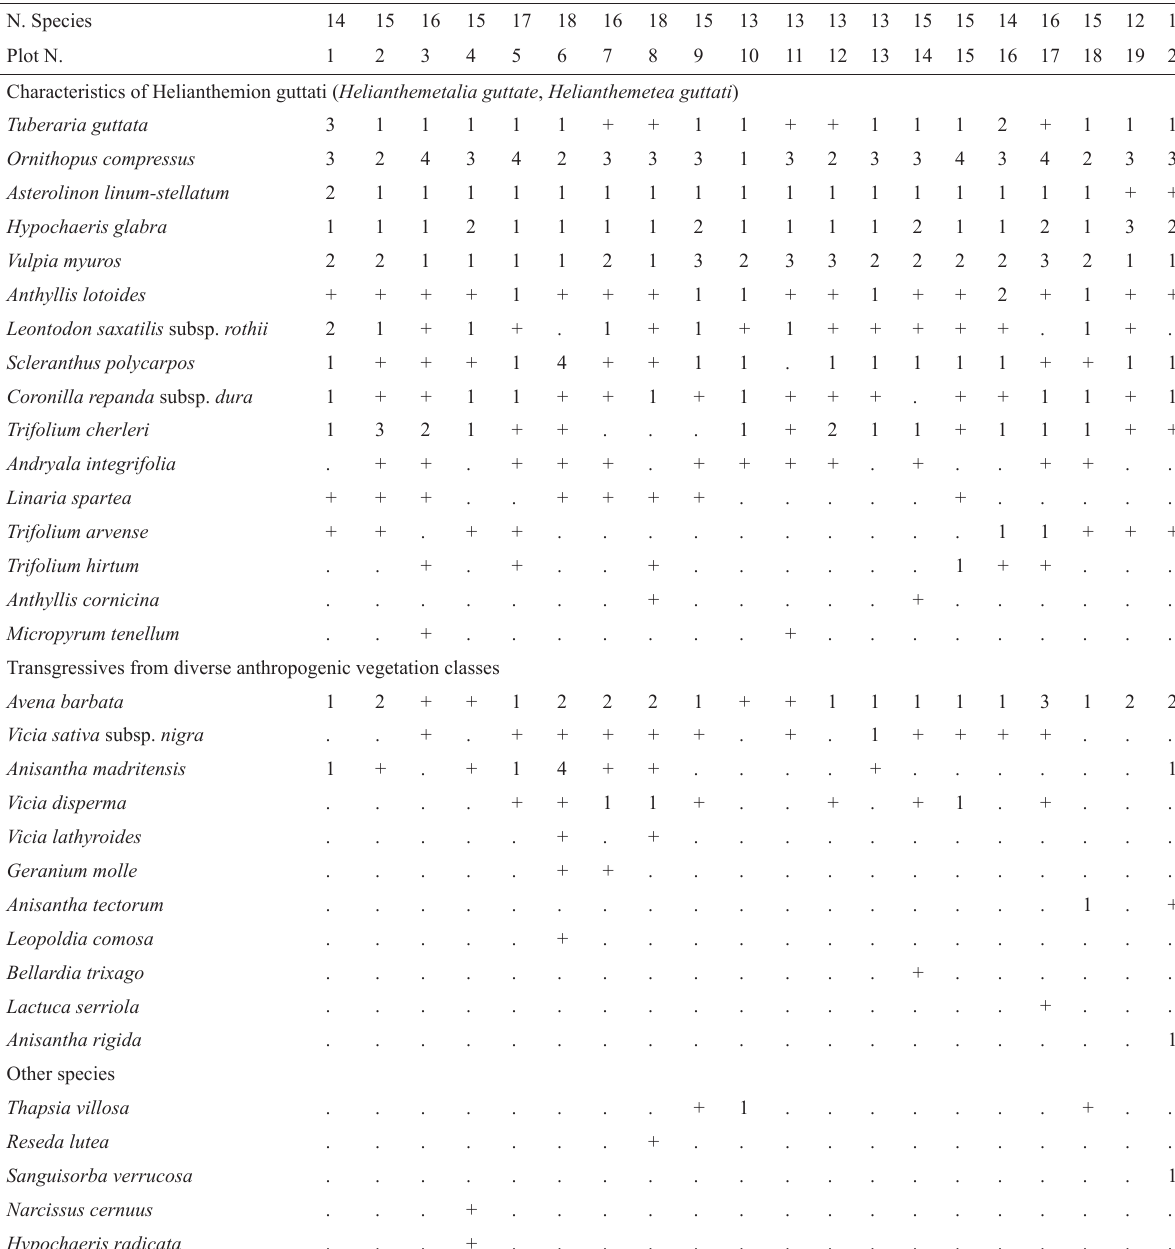
burned). For all plots, the altitude is 800 m asl. Indexes correspond to those of Br.-Bl. 1964. See ,